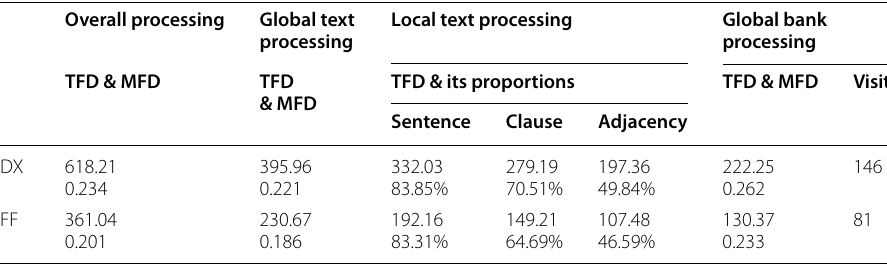
Table 4 DX’s and FF’s eye movement statistics Overall processing Global text Local text processing